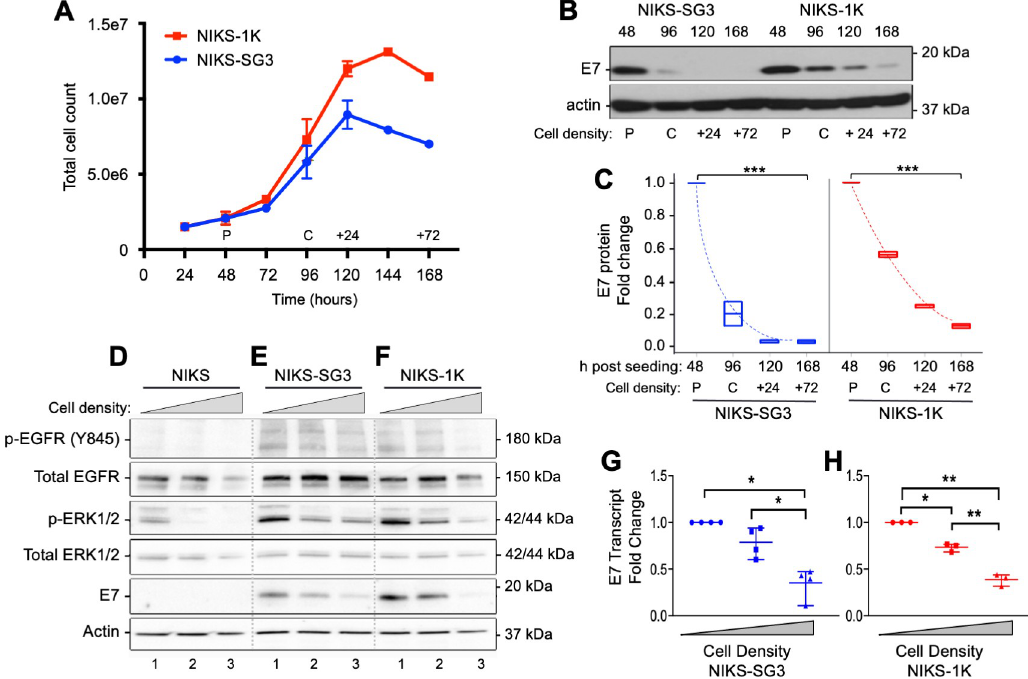
Fig 3. HPV oncoprotein expression is negatively regulated by increasing cell confluence and loss of EGFR/ERK signaling. (A) Growth curves constructed by seeding 1.5x10 6 cells in 21cm 2 plates and counting cells every 24h over 168h (n = 2; error bars = SD). Pre-confluent and confluent cell cultures (denoted as “P” and “C”, respectively) were defined by visual inspection of two biological replicates. (B) Cells were seeded as in (A) and proteins extracted when the cells were 70% (pre-) confluent (P), 100% confluent (C), 24h after reaching confluence (+24), and 72h after confluence (+72), corresponding to times indicated in (A). Protein lysates (25 μ g/lane) analyzed by SDS-PAGE and immunoblot (IB). (C) Densitometry analyses on IB data from two biological replicates as in (B). Box plots represent the median and range of the relative levels of HPV16 E7 protein for each cell density compared to the pre-confluent samples. Analyses included the random effects linear regression model with random slope, quadratic time (F = 521.11, p < 0.0001 for time linear term and F = 226.02, p < 0.0001 for quadratic time term), and interaction effect (F = 17.53, p = 0.0007 for the interaction term). (D-H) In parallel, plates of decreasing surface area (21cm 2 , 9.0cm 2 and 4.6cm 2 ) were seeded with 1.25x10 6 cells, grown for 24h. (D-F) Protein lysates collected 24h post seeding, subjected to SDS-PAGE and IB. (G, H) Total RNA isolated 24h post seeding subjected to RT-qPCR targeting E7 mRNAs, normalized to ribosomal protein18s mRNA levels and lowest cell density sample. Scatter plots represent mean and range of the data, which were analyzed by 1-way ANOVA and Dunnett’s T3 multiple comparison test ( � p < 0.05, �� p < 0.01, ��� p < 0.001). examined (Figs 3D–3F and S2D). Although total levels of EGFR and ERK1/2 were unaltered or slightly diminished by increasing cell density of NIKS and the two HPV16(+) NIKS cell lines, both p-EGFR (Y845) and p-ERK1/2 were suppressed (Fig 3D–3F). Similar results were seen in the CIN 1-derived HPV16(+) W12-E cell line, the HPV18(+) NIKS-H18 cell line, and the CIN 1-derived HPV31(+) CIN-612 9E cell line, (S2D Fig). The suppression of EGFR/MEK/ERK signaling with increasing cell density correlated with reduced HPV oncoprotein levels and their mRNA transcripts. Increasing cell density led to reduced E7 protein levels in HPV16(+) and HPV18(+) cells (Figs 3E, 3F, S2D and S2E). Although challenging to detect in most HPV infected cells, E6 protein levels were also reduced following increasing cell density (S2D and S2E Fig). Lacking antibodies that detect HPV31 E6 and E7 proteins, we were unable to correlate the reduced EGFR activity with HPV31 oncopro- tein expression (S2C Fig). Transcriptional suppression of HPV E6 and E7 mRNAs closely fol- lowed the cell-regulated decreases in EGFR/MEK/ERK signaling in each HPV(+) cell line tested (Figs 3G, 3H, S2F and S2G). These data suggest that HPV oncogene transcription is closely tied to EGFR/MEK/ERK signaling.